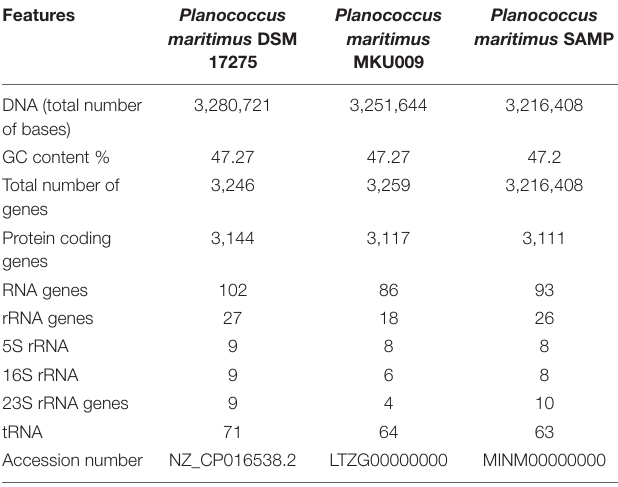
TABLE 1 | Showing general genome features of the genome under study. Features